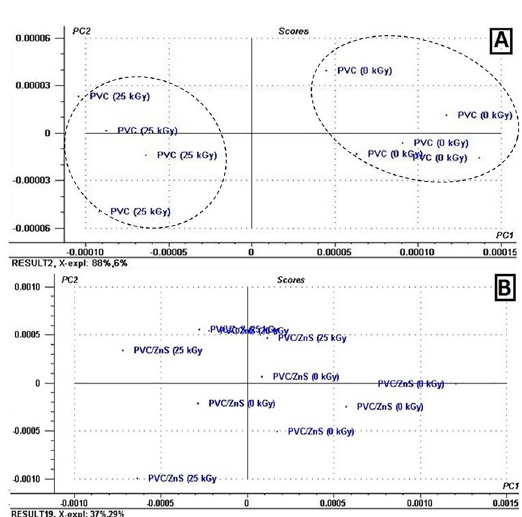
Figure 8. Score plots of PC1 x PC2 of irradiated systems for a) PVC and b)